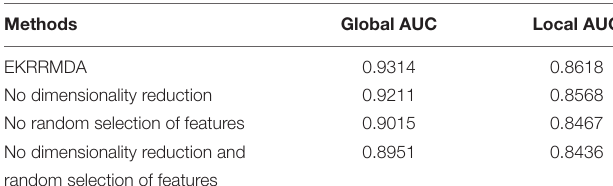
TABLE 3 | Comparison of global AUC and local AUC between EKRRMDA and variants of EKRRMDA under